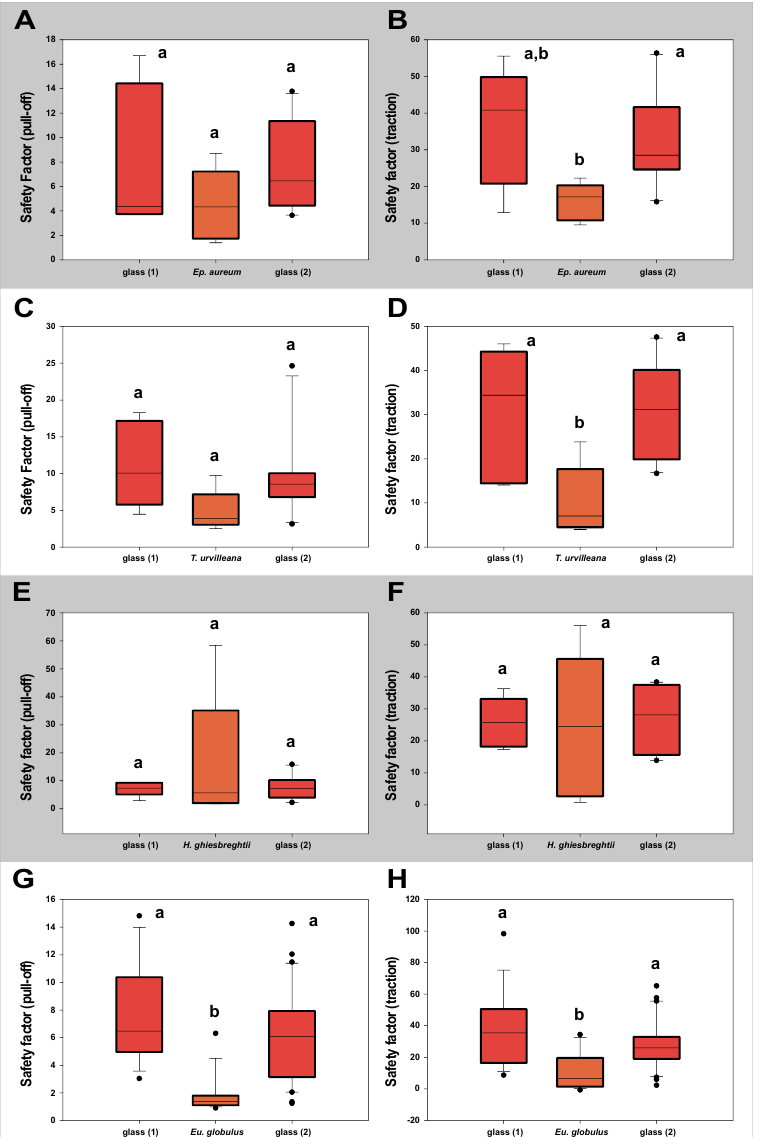
Figure 7. Contamination effect of the substrates tested with S. inexpectata shown through safety factor. ( A ) Ep. aureum, pull-off force. ( B ) Ep. aureum, traction force. ( C ) T. urvilleana, pull-off force. ( D ) T. urvilleana, traction force. ( E ) H. ghiesbreghtii, pull-off force. ( F ) H. ghiesbreghtii, trac- tion force. ( G ) Eu. globulus, pull-off force. ( H ) Eu. globulus, traction force. Statistically similar groups within a graph are marked with the same lowercase letter. ( A ): Kruskal–Wallis one-way ANOVA on ranks (H = 1.054, d.f. = 2, N glass1,Ep.aureum = 5, N glass2 = 10, p = 0.331); ( B ): one-way ANOVA (F = 4.013, d.f. = 2, N glass1,Ep.aureum = 5, N glass2 = 10, p = 0.037; Holm–Š í d á k method, p < 0.05); ( C ): Kruskal–Wallis one-way ANOVA on ranks (H = 4.817, d.f. = 2, N glass1,T.urvillena = 5, N glass2 = 10, p = 0.09); ( D ): one-way ANOVA (F = 5.927, d.f. = 2, N glass1,T.urvillena = 5, N glass2 = 10, p = 0.011); Holm–Š í d á k method ( p < 0.05); ( E ): one-way ANOVA (F = 5.927, d.f. = 2, N glass1,T.urvillena = 5, N glass2 = 10, p = 0.011); Holm–Š í d á k method ( p < 0.05); ( F ): Kruskal–Wallis one-way ANOVA on ranks (H = 0.189, d.f. = 2, N glass1,H.ghiesbreghtii = 5, N glass2 = 10, p = 0.910); ( G ): Kruskal–Wallis one-way ANOVA on ranks (H = 25.805, d.f. = 2, N glass1,Eu.globulus = 15, N glass2 = 30, p ≤ 0.001), Dunn’s method ( p < 0.05); ( H ): Kruskal–Wallis one-way ANOVA on ranks (H = 17.517, d.f. = 2, N glass1,Eu.globulus = 15, N glass2 = 30, p ≤ 0.001; Dunn’s method ( p < 0.05). The boxes indicate 25th and 75th percentiles, whiskers define the 10th and 90th percentiles and the line within the boxes represents the median. Outliers are shown as individual